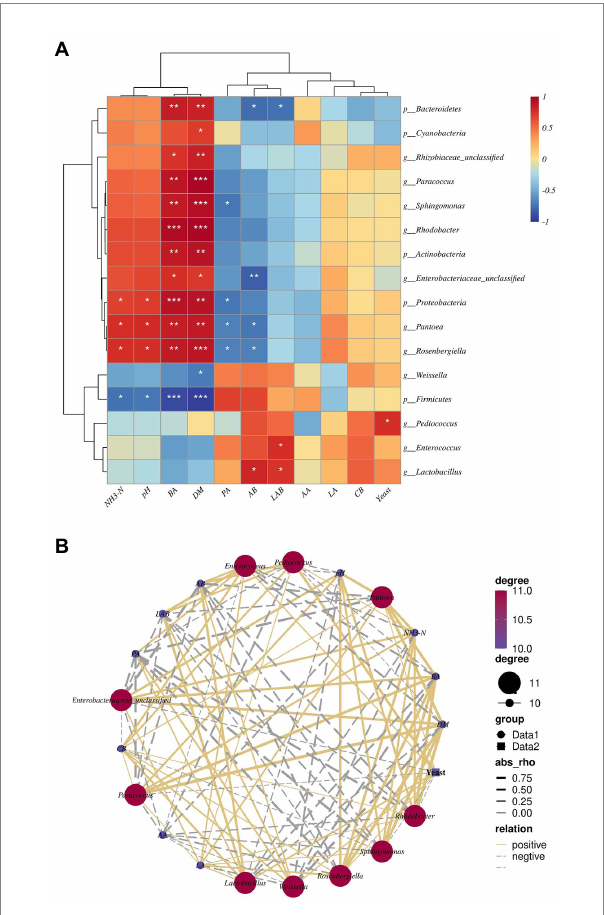
FIGURE 7 (A) Spearman correlation heatmap of the top tenth bacterial phylum, genus, and fermentation properties. (B) Correlation network among main bacterial genera top tenth and fermentation properties. The values presented by colors in the heat map correspond to the Spearman correlation coefficient r, which ranged between − 1 and 1, where r < 0 indicates a negative correlation(blue), r > 0 indicates a positive correlation (red), “*” represents p < 0.05, “**” represents p < 0.01, “***” represents p < 0.001. In(b), absolute value of correlation coefficient > 0.5 and p < 0.05. LA, lactic acid; AA, acetic acid; PA, propionic acid; BA, butyric acid; DM, dry matter; CB, number of coliform bacteria; LAB, number of lactic acid bacterial; Yeast, number of yeast; AB, number of Aerobic